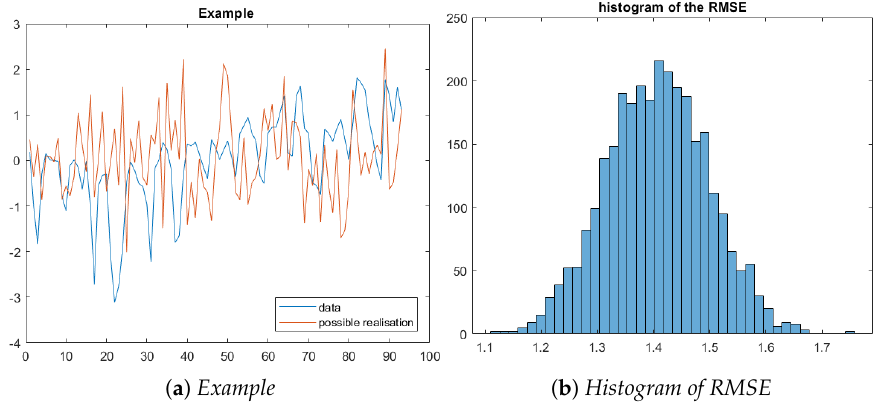
Figure 9. Example of a possible realisation with standardised data.